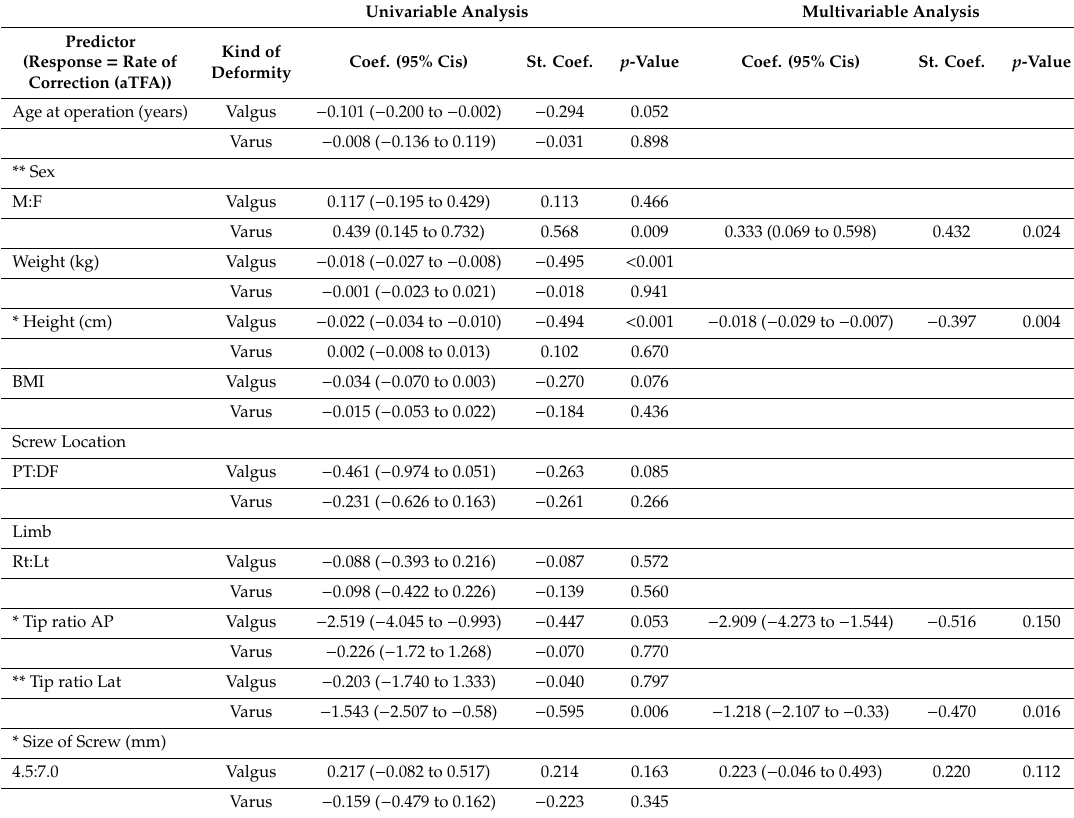
Table 6. Results of univariable and multivariable linear regression analysis using the correction rate (aTFA) as a response in valgus and varus